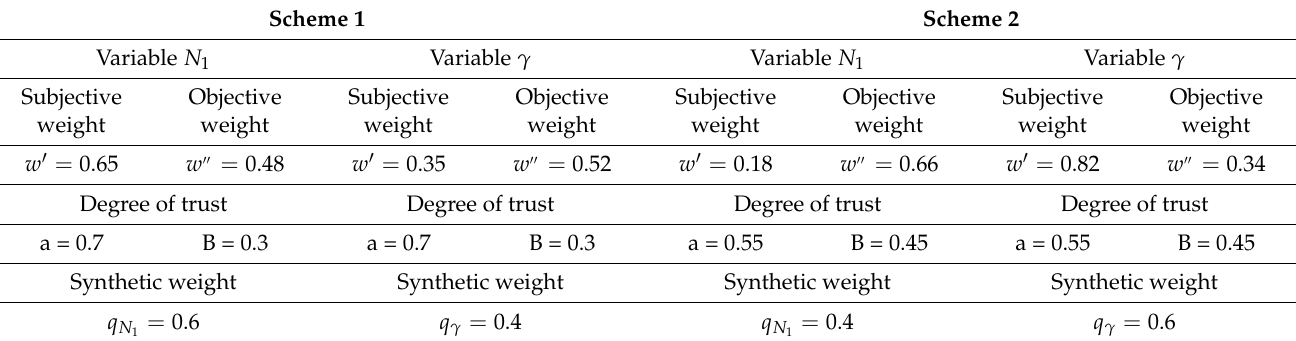
Table 4. Two kinds of synthetic weight calculation